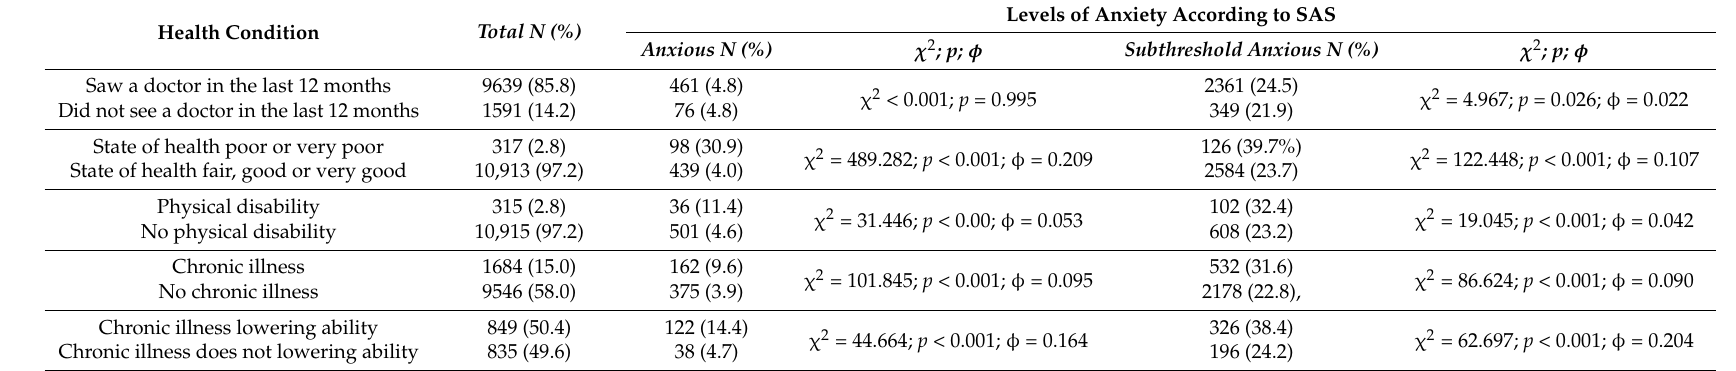
Table 2. Prevalence of anxiety in the study